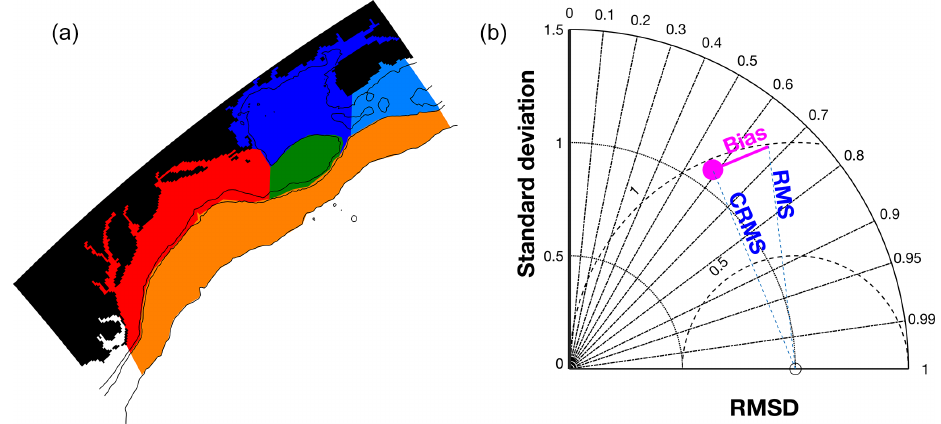
Figure 6. (a) The five-model domain subregions used to better distinguish geographic variation in skill performance. (b) Schematic Taylor diagram. Radial distance is the model standard deviation normalized by observation standard deviation; azimuth is the arc cosine of the correlation; distance to point (1, 0) on the x axis (dashed lines labeled 0.5 and 1) is the normalized centered RMS error. Stick indicates normalized mean bias of the model; distance from the end of the stick to (1, 0) is the overall normalized RMS error including bias. The closer to (1, 0), the better the performance. RMSD: root mean square deviation.